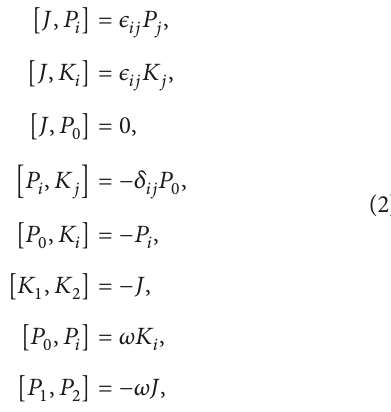
𝜔 Space of worldlines S (1) with curvature